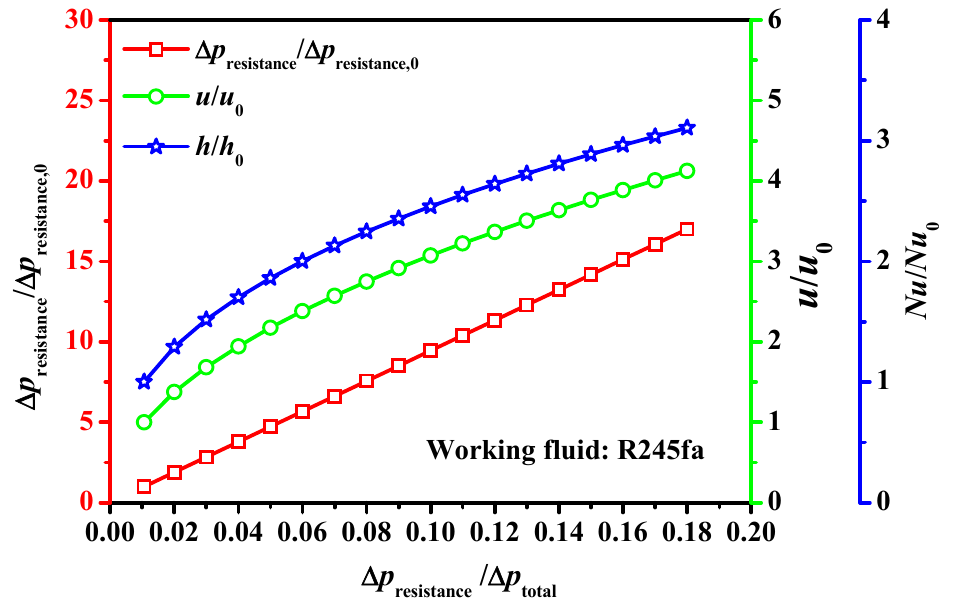
Figure 7. Variation of ∆ p resistance / ∆ p resistance,0 , u / u 0 and Nu / Nu 0 with ∆ p resistance / ∆ p total